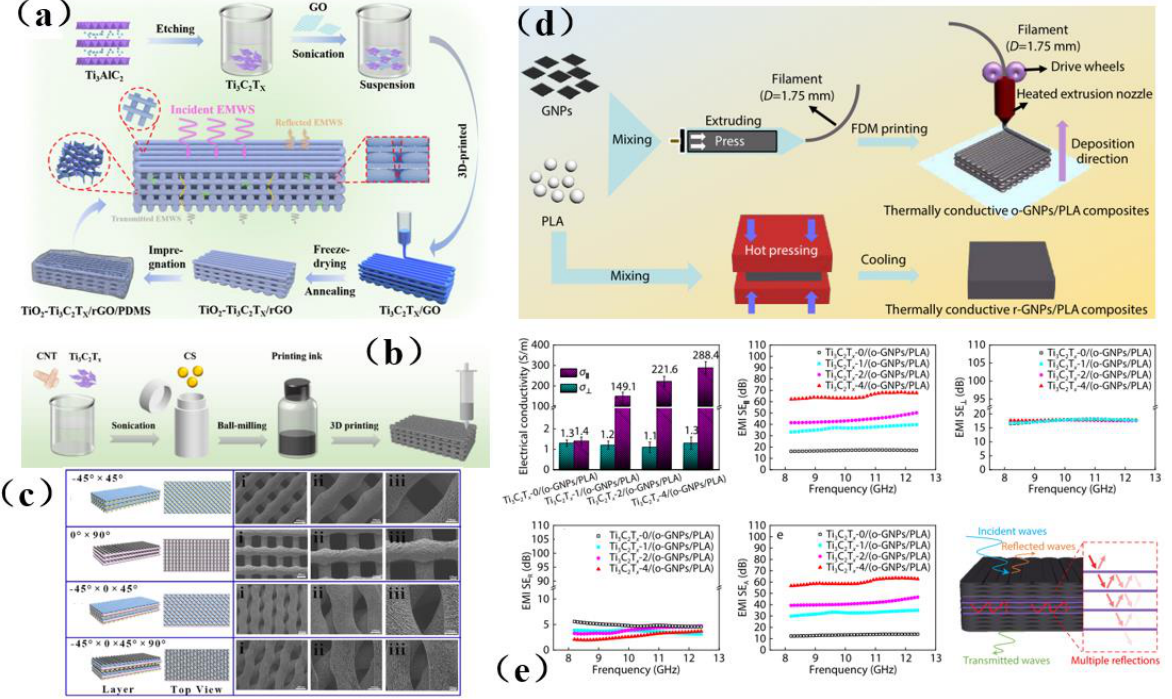
Figure 14. ( a ) Schematic diagram of preparation depicting the Ti 3 C 2 T x /rGO/PDMS composite [128]. Copyright 2022, Elsevier. ( b ) Preparation process of CNT/ Ti 3 C 2 T x /CS ink and its 3D printing composite carbon nanotubes; CS, chitosan. ( c ) Schematic diagram depicting the preparation of porous 3D printed composites with different structures. b, c [129]. Copyright 2022, Wiley. ( d ) Schematic diagram depicting the preparation of thermal conductive GNPs/PLA composites. ( e ) EMI SE and EMI shielding diagram of Ti 3 C 2 T X /(O − GNP/PLA) thermal conductive composite. d, e [126]. Copy- right 2022, Chinese Chemical Society and Institute of Chemistry.